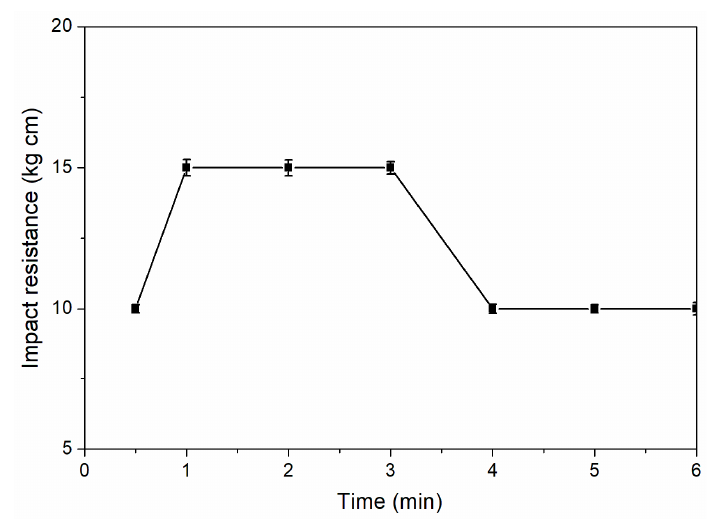
Coatings 2020 , 10 , x FOR PEER REVIEW 11 of 13 Figure 8. E ff ect of drying time on impact resistance of the coating. Figure 8. Effect of drying time on impact resistance of the coating.